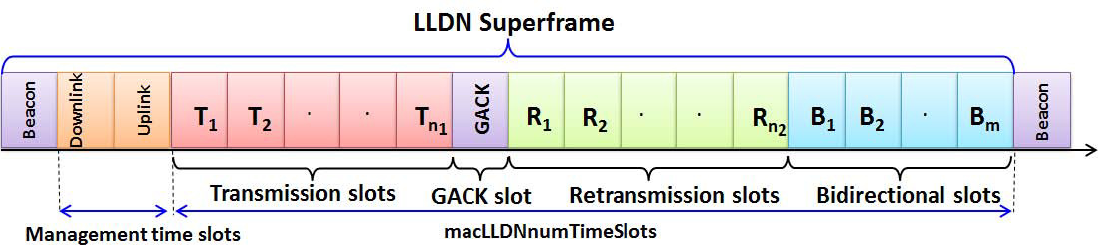
Figure 1. LLDN superframe structure with separate group acknowledgment